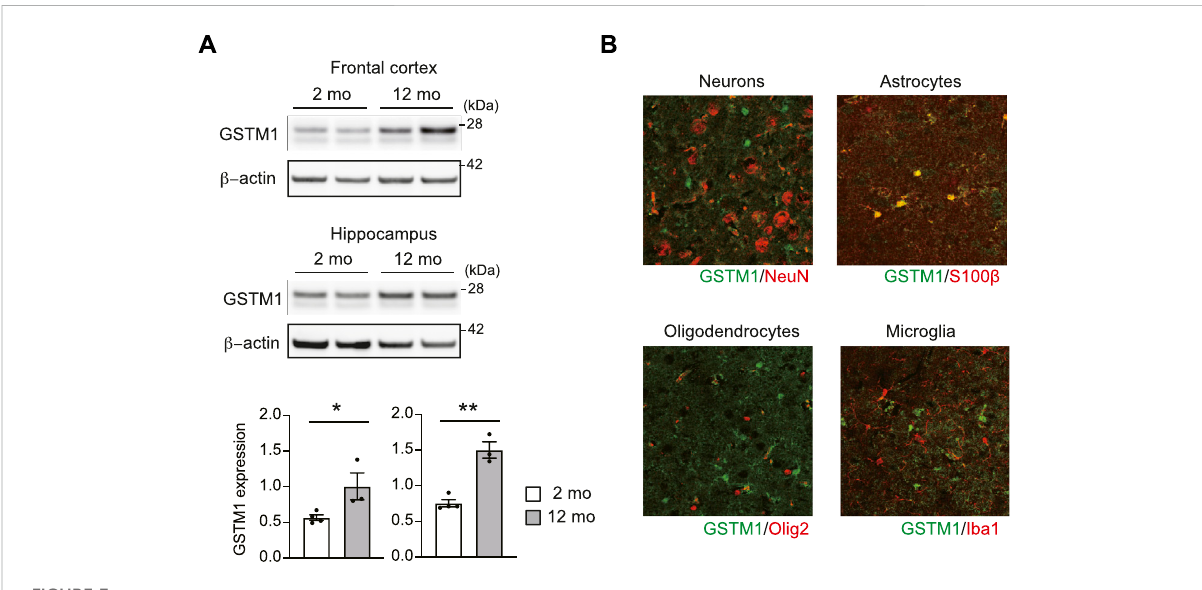
FIGURE 3 Increased expression of GSTM1 in the aging brains. Western blot for GSTM1 proteins. β -actin was used as a loading control. Quanti fi cation of GSTM1 expression relative to β -actin was shown in graphs (mean ± SEM) ( n = 3-4 per group) (A) . Immunohistochemistry of GSTM1 and cell